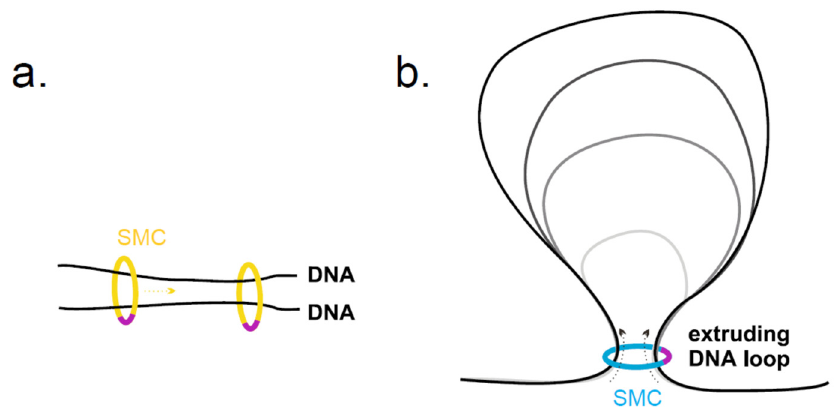
Figure 2. The SMC rings can topologically embrace two DNA strands. The circular shape and the size of the SMC rings enable them to encircle two DNA strands. Two DNA strands can originate from either two sister chromatids ( a ); (cohesin and SMC5/6 can interconnect two DNA strands [66,67]) or two segments of the same DNA molecule ( b ); (most SMC complexes are proposed to form intramolecular loops on DNA). ( a ) ATP binding and hydrolysis provide the SMC complexes with motor activity which allows their translocation along the DNA molecule. ( b ) SMC motor activity may also progressively enlarge loops of DNA in a process termed loop extrusion. Given the loop extrusion activity of the SMC/ScpAB and condensin complexes [64,65], it is very likely that SMC5/6 complexes can also form intramolecular loops on DNA.